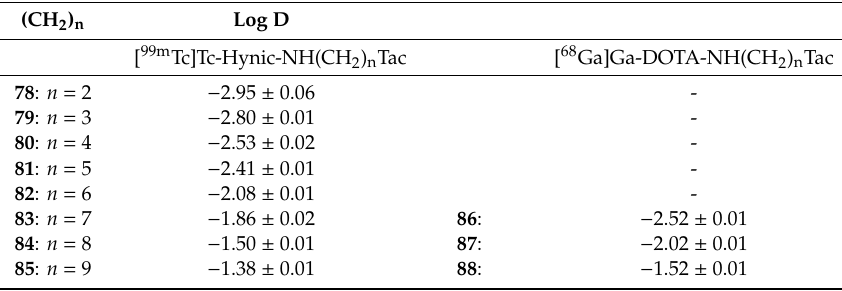
Figure 21. Tacrine–based 99m Tc 3+ coordination compounds 78–85 and Ga 3+ coordination compounds Figure 21. Tacrine-based 99m Tc 3 + coordination compounds 78 – 85 and Ga 3 + coordination compounds 86–88 with Hynic and DOTA metal–chelating moieties, designed for PET imaging of A β plaques. 86 – 88 with Hynic and DOTA metal-chelating moieties, designed for PET imaging of A β plaques. Table 3. Log D values for coordination compounds 78 – 88 An ability of coordination compounds 82 and 86 to inhibit acetylcholinesterase (AChE) and butyrylcholinesterase (BuChE) was estimated using Ellman’s colorimetric assay. The half maximal inhibitory concentration IC 50 values for the tested derivatives are presented in Table 4. Tacrine was used as the reference inhibitor. Table 3. Log D values for coordination compounds 78–88.